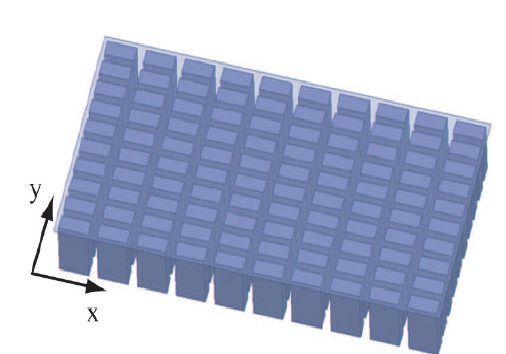
FIGURE 8. HFSS-based open ended 10 𝗑 10 waveguide array for the diagnostic